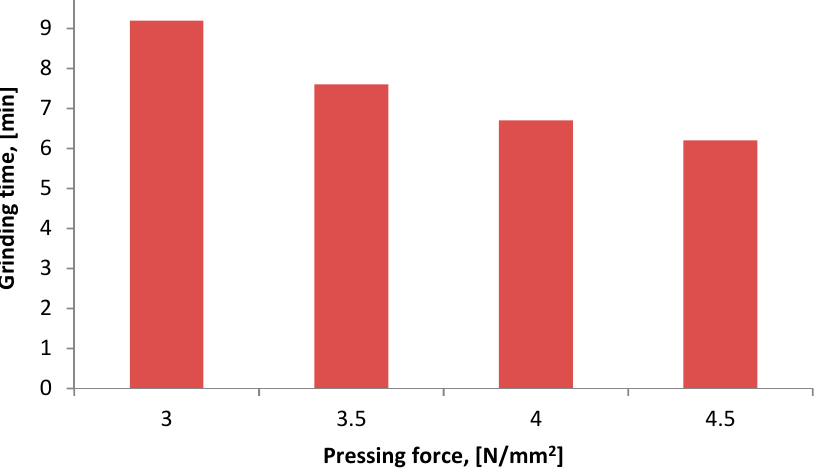
Figure 12. Relationships between the grinding time and operational pressing force on example of obtaining 80% of grinding product below 0.1 mm.